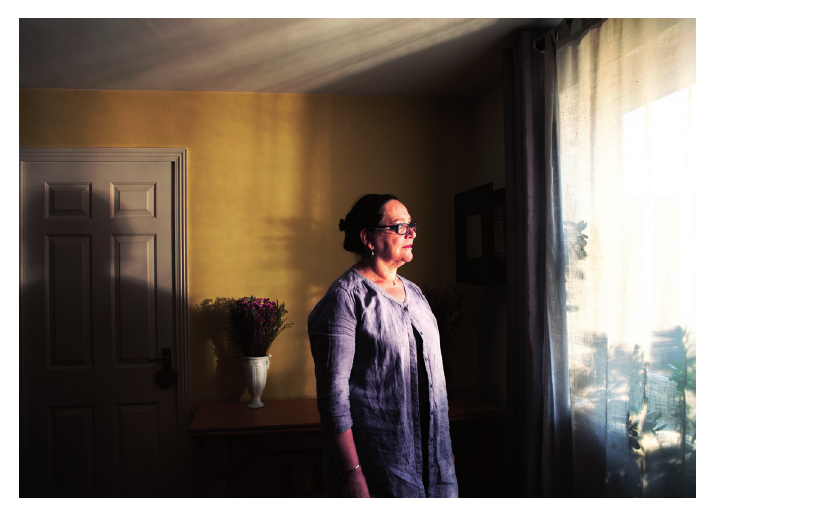
Figure 1: From the series ‘The Journey’